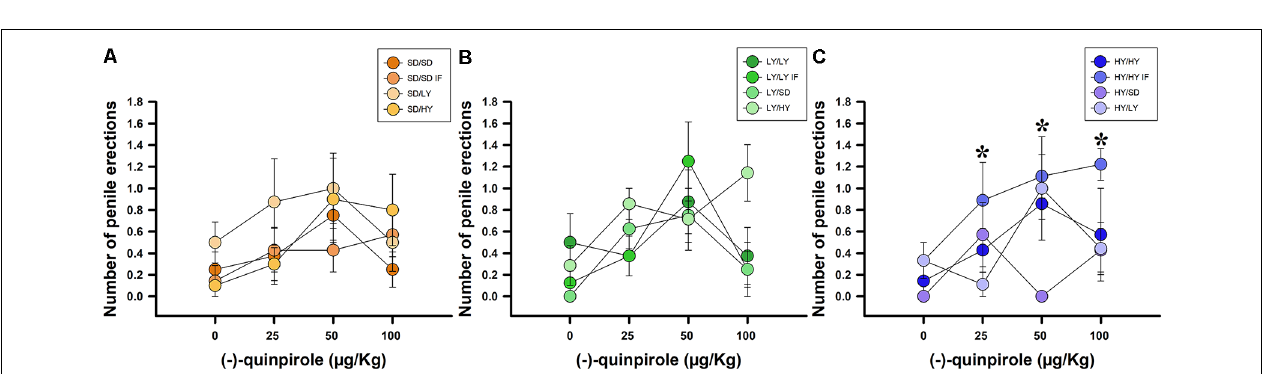
FIGURE 7 | Systemic administration of ( − )-quinpirole increased penile erection frequencies in all groups of rats. (A) SD dams that raised HY male rats (SD/HY) showed higher penile erection frequencies with respect to the other pairs of dams/male rats. (B) LY male rats do not differ in penile erection frequencies with respect to the phenotype of the dam that raised them. (C) HY male rats in-fostered with another HY dam (HY/HY IF) had the highest penile erection frequencies with respect to the other pairs of HY male rats (* P < 0.05).